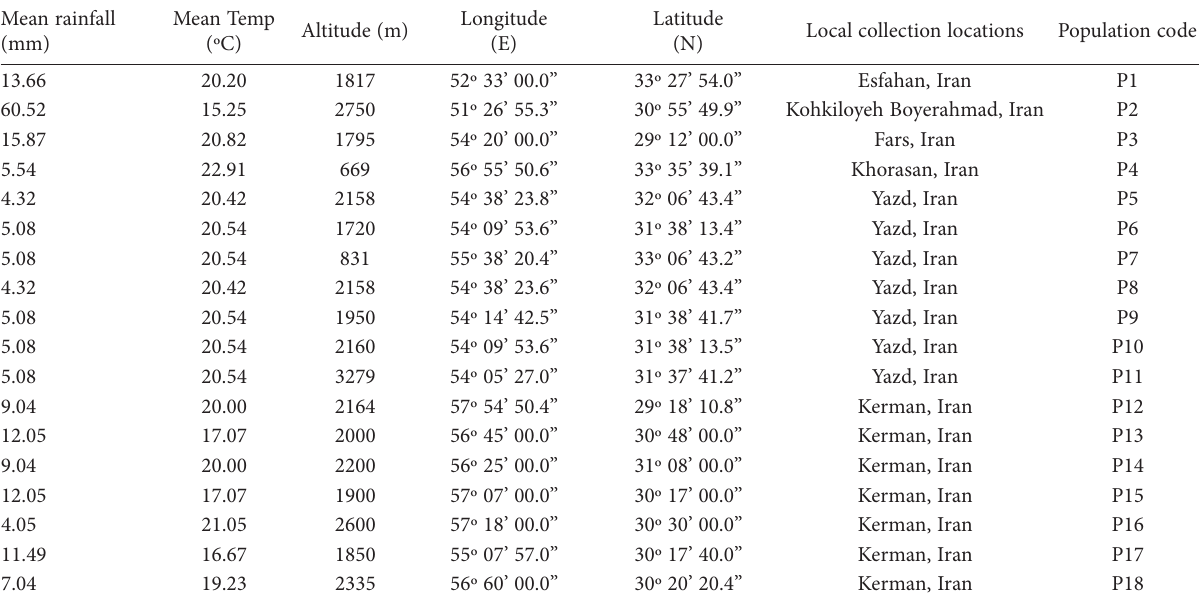
Table 1. Local information of the collected Iranian endemic Ferula assa-foetida L. Mean rainfall